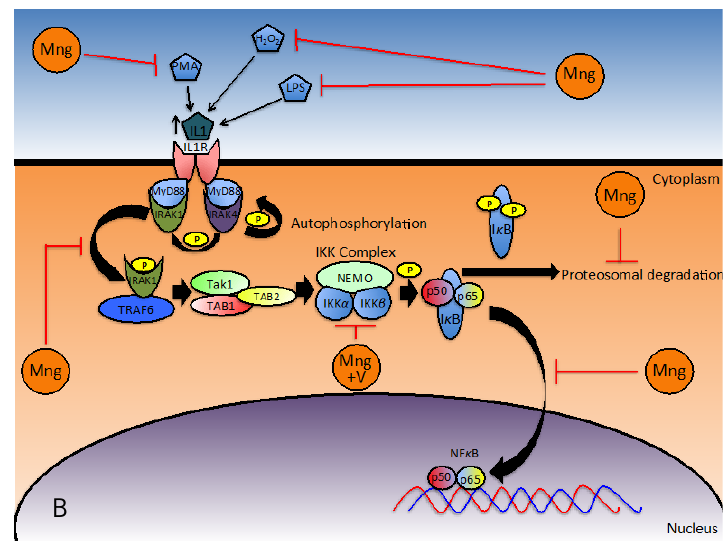
Figure 2. Inhibition of NFκB via the ( A ) classical and ( B ) alternative pathways by mangiferin and Vimang (adapted from [11,45,55]) (abbreviations: Mng, mangiferin; V, Vimang ® ). Initial Stimulus for NFκB Activation